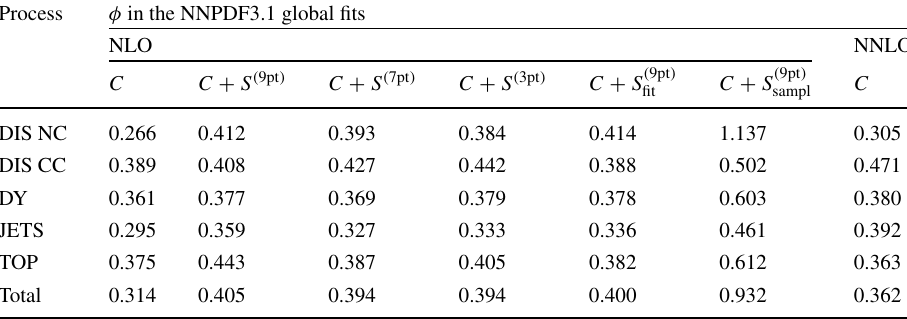
Table 8 Same as Table 7, but for the values of the φ estimator